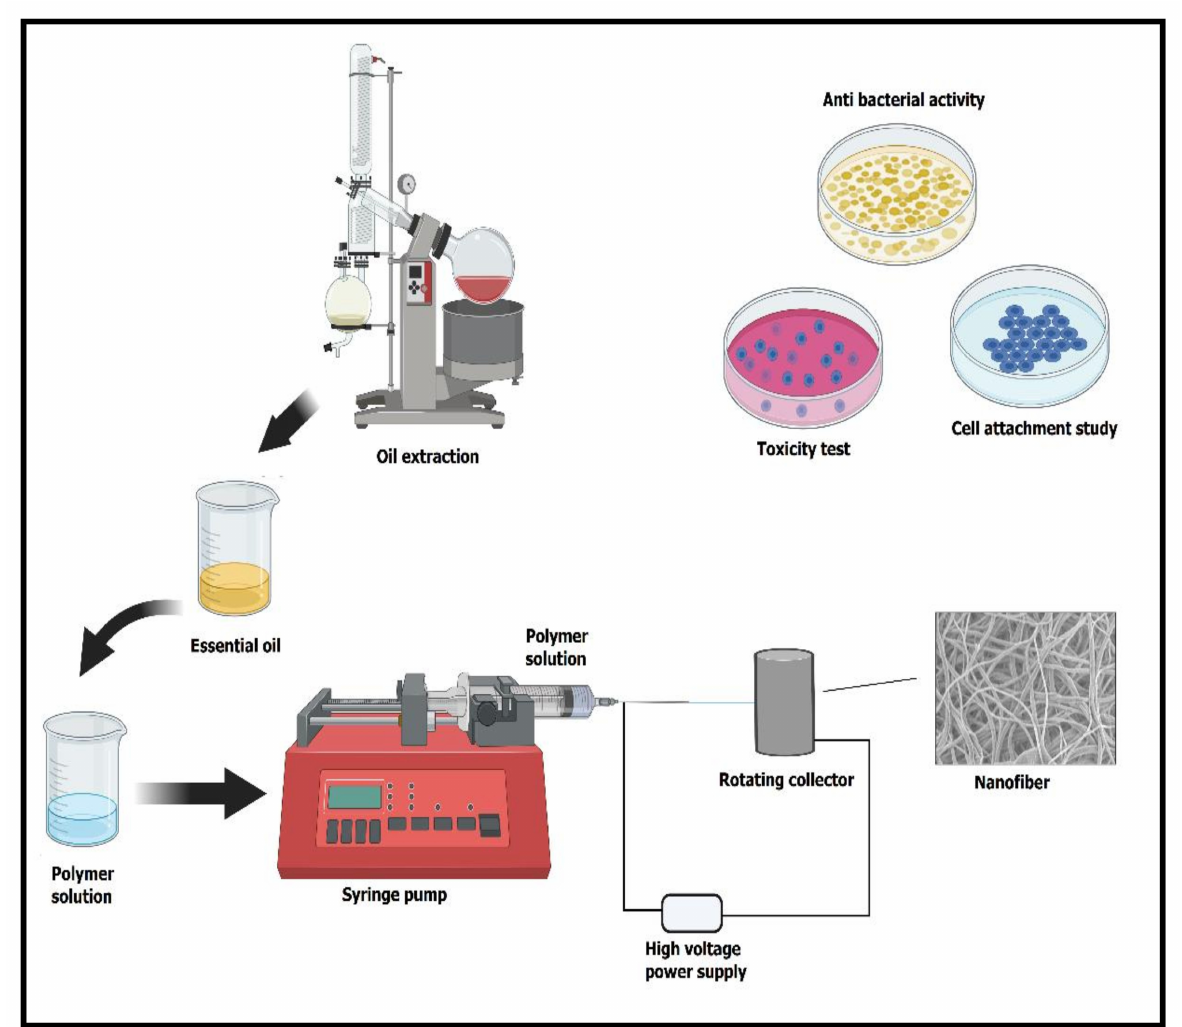
Figure 4. The systematic presentation of the encapsulation of lavender oil in polyurethane nanofibers using the electspinning